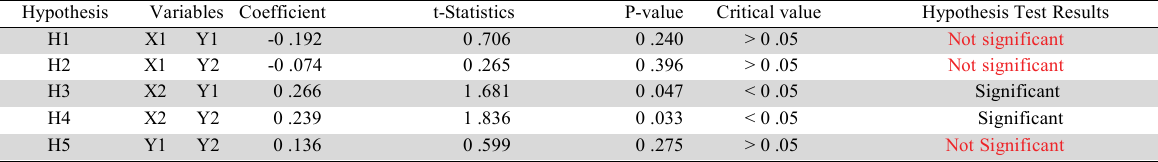
Hypothesis Test